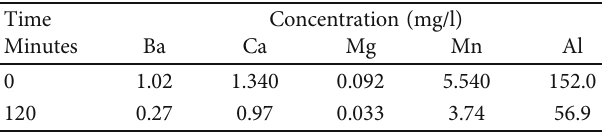
Table 3: Concentration of nonheavy metals after di ff erent time